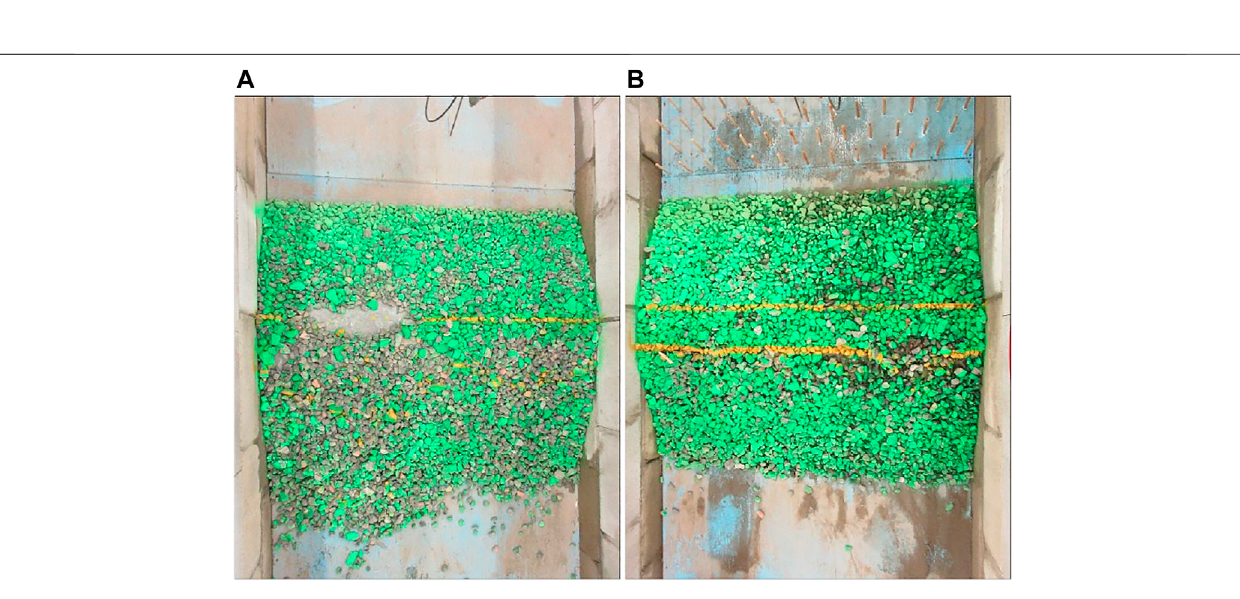
Frontiers in Built Environment |